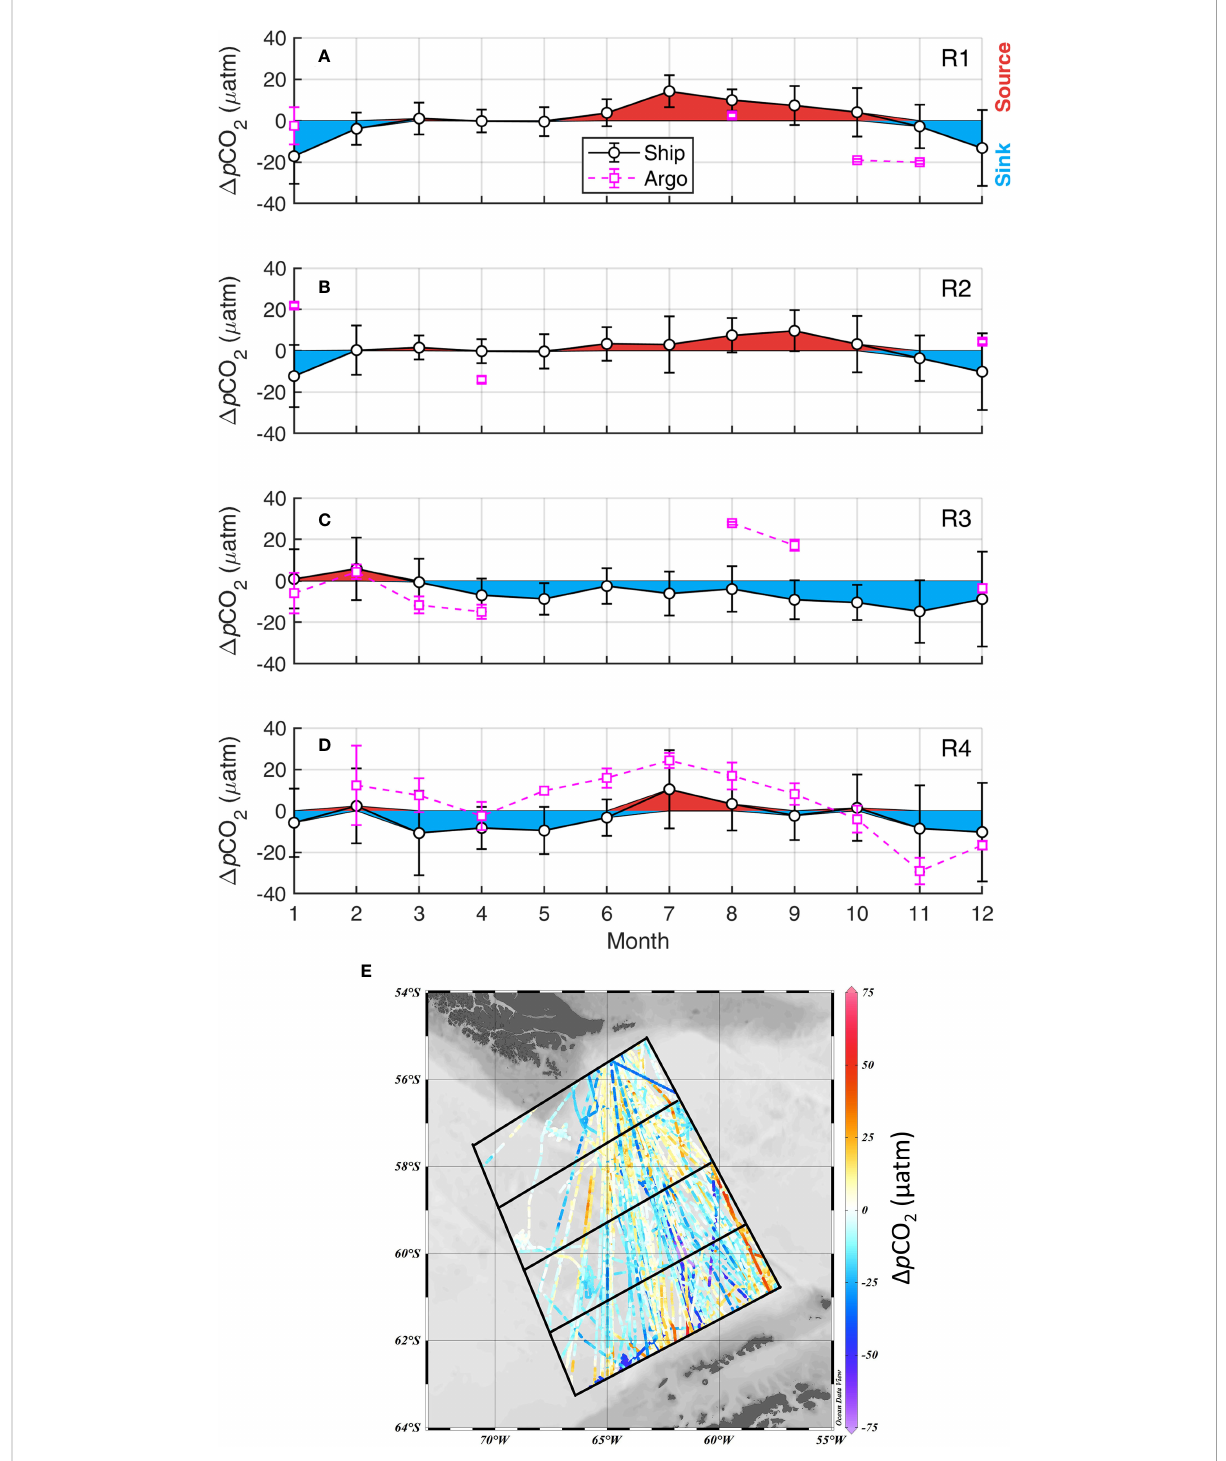
FIGURE 6 The comparison between ship-based and fl oat-based monthly D p CO 2 in each region of the Drake Passage. (A – D) monthly D p CO 2 in different regions from R1 to R4. (E) the spatial pattern of D p CO 2 . D p CO 2 means difference between the sea surface and atmospheric p CO 2 . The error bars represent the standard deviations of monthly mean